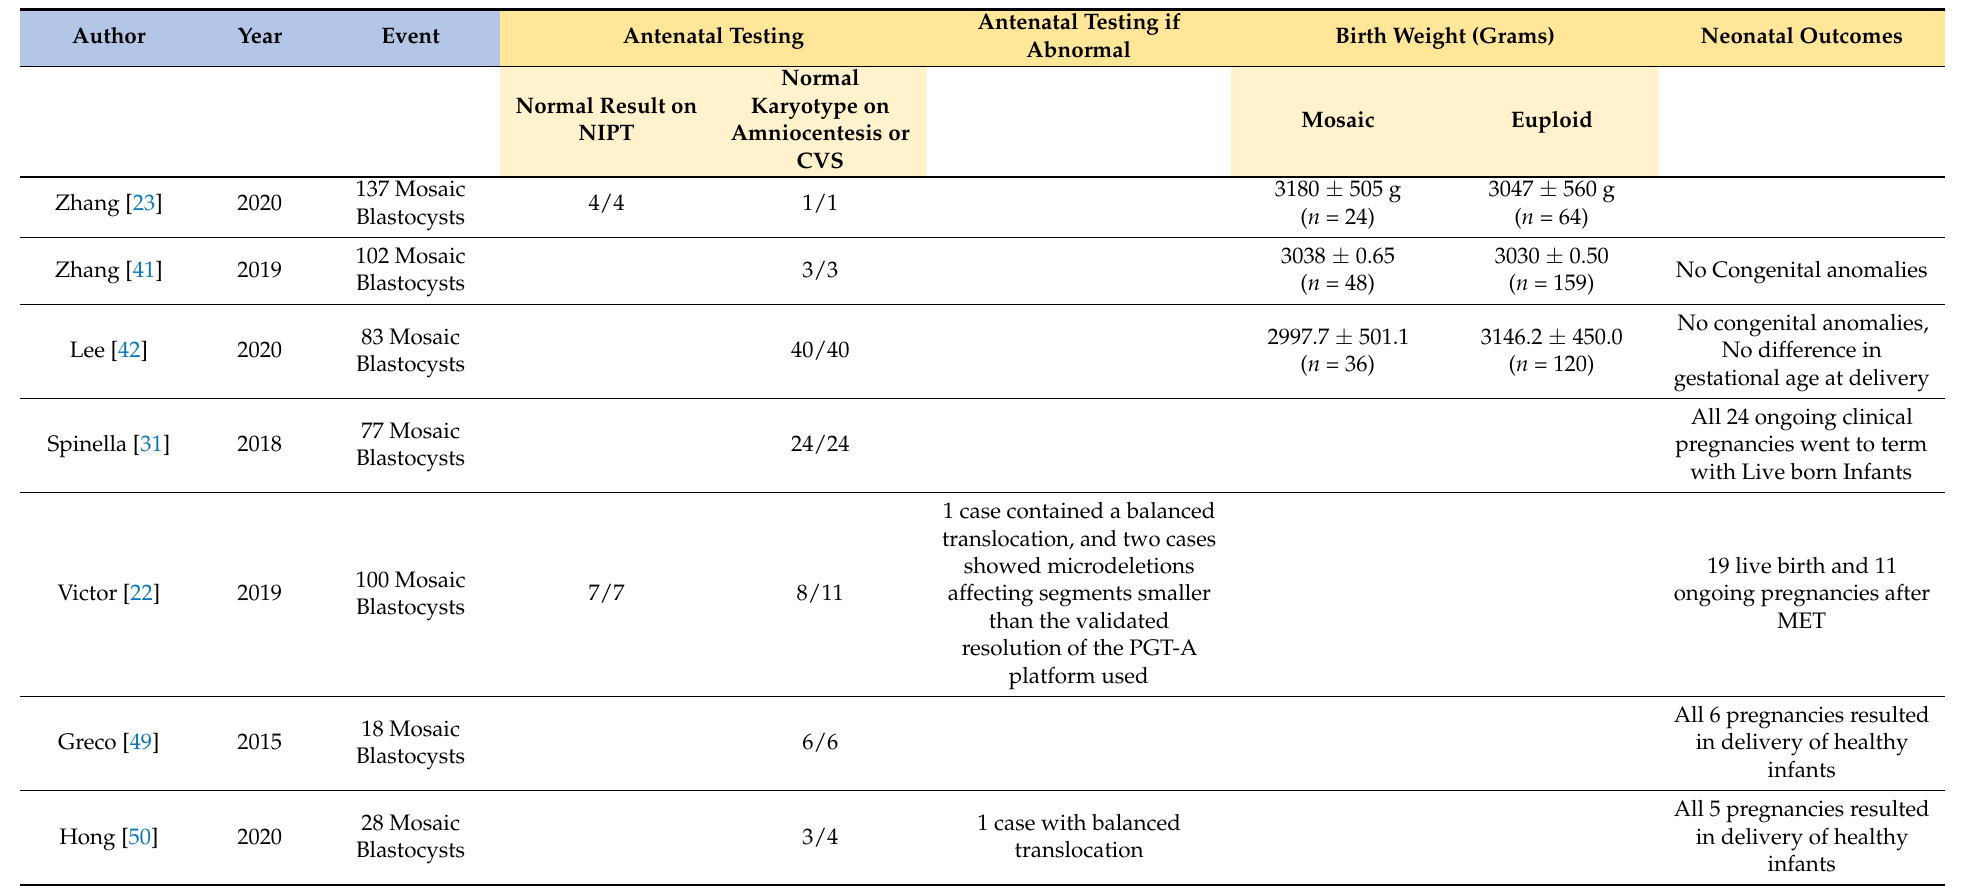
Table 2. Prenatal diagnostic/screening results and neonatal outcomes after